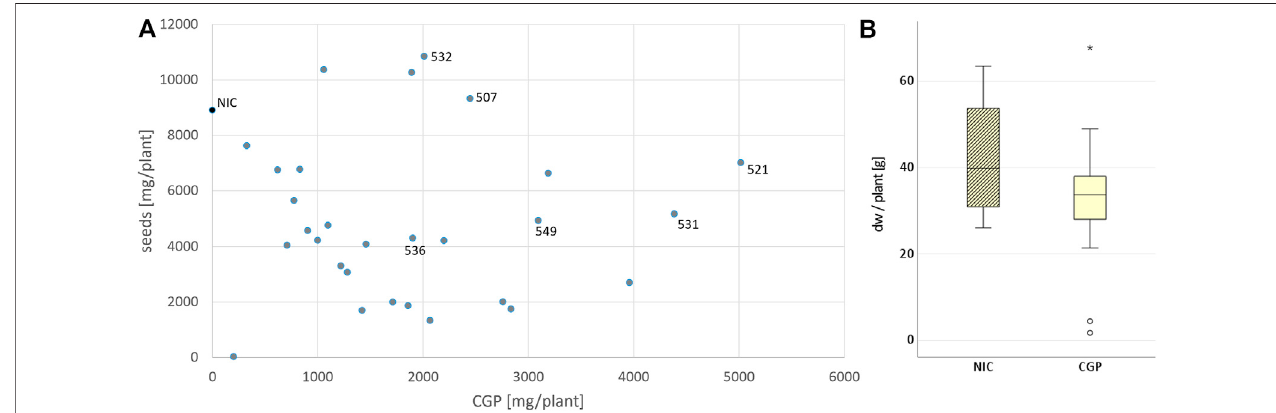
FIGURE2| In fl uenceofCGPproductionontheleafandseedyield. (A) DistributionoftheCGPandseedyieldamongalleventsandselectedevents. (B) Variationin the biomass (in dw/plant) in the NIC and all T0 events.